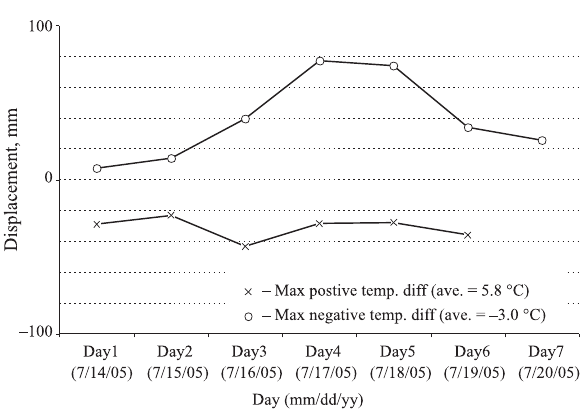
Fig. 7. Relative vertical displacement of slab at max temperature diff erence